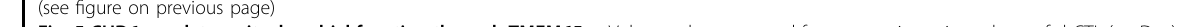
Fig. 5 CHD6 regulates mitochondrial function through TMEM65. a Volcano plot generated from transcriptomic analyses of shCTL (no Dox) and sh CHD6 (Dox) HCT116 cells. Dox, doxycycline. b Representative images of IHC staining for TMEM65 in human colon cancer and adjacent normal colon tissue (top). A plot showing the relative expression of TMEM65 in 76 paired samples of CRC and adjacent normal colon tissue (bottom). Scale bars, 50 μ m. c Kaplan-Meier survival curves of overall survival duration based on TMEM65 protein expression in the 104 CRC patient tissues. The receiver operating characteristic curve was used to de fi ne the cutoff, and log-rank analysis was used to test for signi fi cance. d RT-qPCR analysis of TMEM65 in HCT116 cells expressing CHD6 shRNA with or without Flag-tagged CHD6 overexpression. e Growth curves of CHD6 KD HCT116 cells in the presence of TMEM65 overexpression (left); RT-qPCR analysis con fi rmed the ef fi ciency of TMEM65 overexpression (right). f RT-qPCR analysis of CHD6 and TMEM65 in CHD6 KD HCT116 subcutaneous tumors from Fig. 1d. g Representative images of IHC staining for CHD6, TMEM65, Ki67, and PPOX in subcutaneous tumor sections from Fig. 1d (top) and quanti fi cation of IHC staining by ImageJ (bottom). h OCR of HCT116 cells with TMEM65 overexpression. i OCR of shCTL and sh CHD6 HCT116 cells, with or without TMEM65 overexpression. j Quanti fi cation of cellular ATP in shCTL and sh CHD6 HCT116 cells, with or without TMEM65 overexpression. k Immunoblot analysis of PPOX expression in shCTL and sh CHD6 HCT116 cells. l Heme levels in control and CHD6 KD HCT116 cells, with or without TMEM65 overexpression. m Representative images of IHC staining for CHD6, TMEM65, PPOX, COXIV, OPA1, and p-Drp1 (Ser616) in the colon tissues obtained from the indicated mice with AOM/DSS treatment. Quanti fi cation of IHC staining shown at the bottom (samples from at least 3 – 6 mice for each genotype were analyzed). Assays were performed with three replicates. P values were calculated by two-tailed t -test ( b , g , m ), one-way ANOVA ( d – f , j , l ), or two-way ANOVA ( e ). Data are presented as means ± SD. *** P < 0.001, ** P < 0.01, * P < 0.05, ns, not signi fi